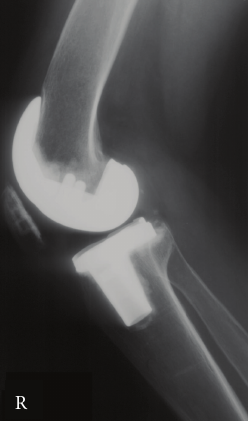
Figure 2: Lateral radiograph of the right knee. A small effusion is present as well.